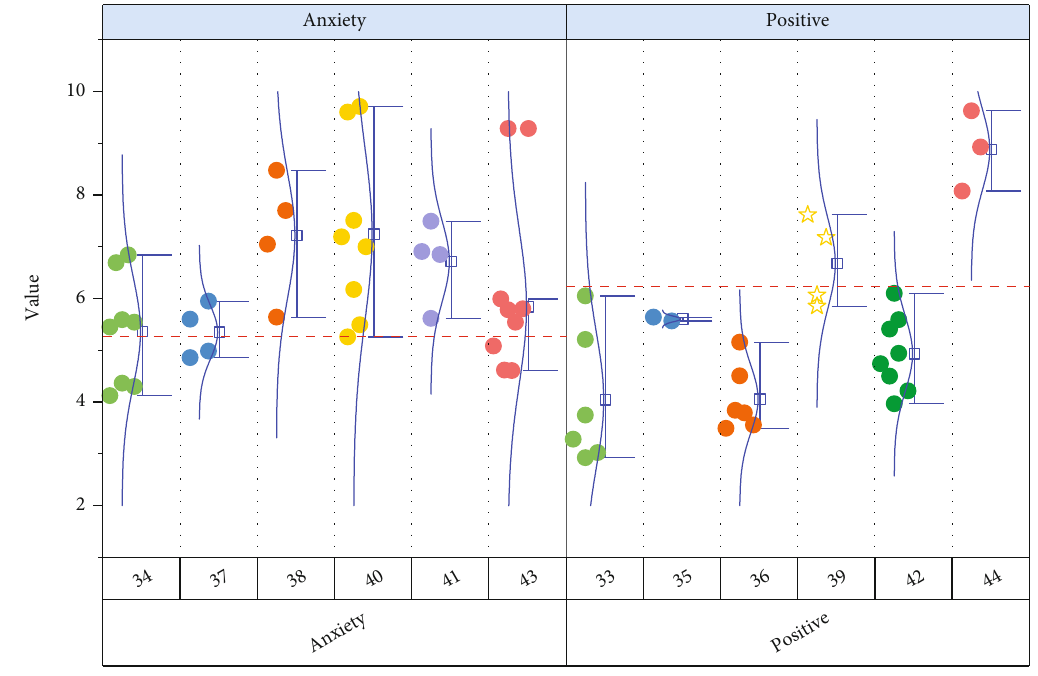
Figure 3: Statistical results of extreme emotions.